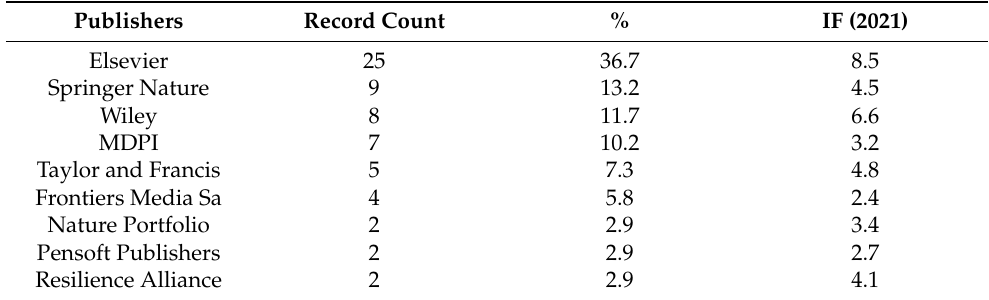
Table 5. Top 9 most productive journals in the field of ESs in southern Africa for the period 2021. Publishers